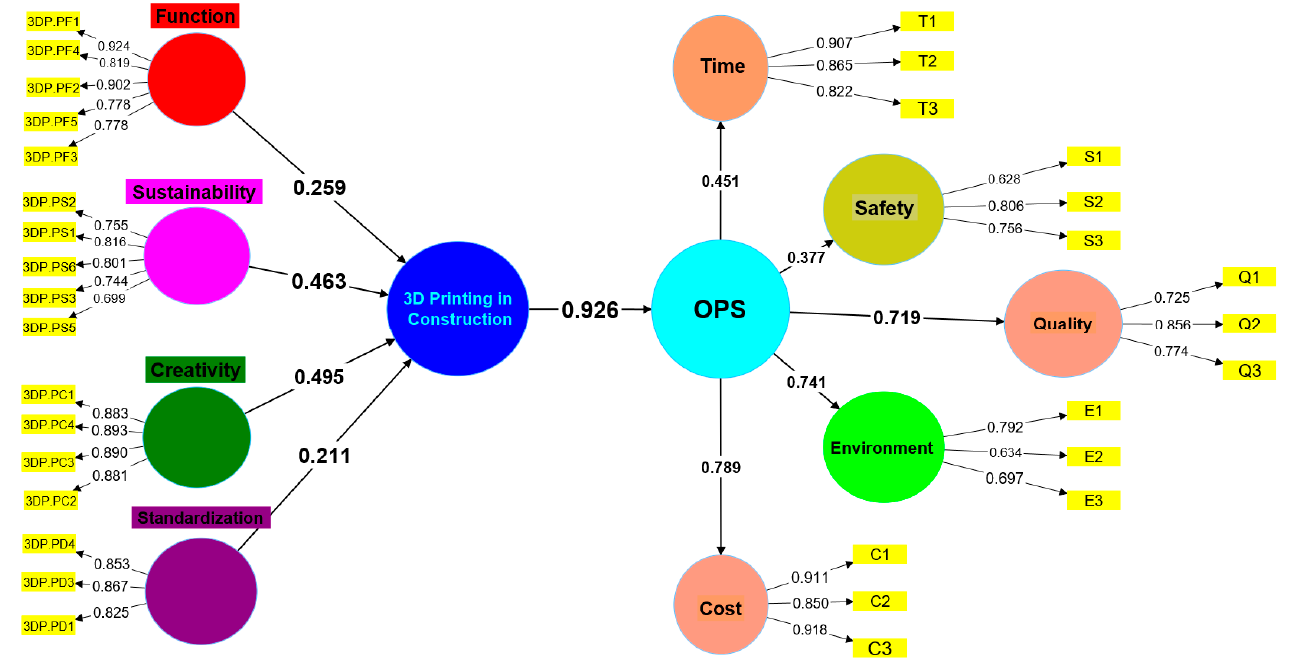
Figure 4. Structural model with path coefficients. Table 5. Correlations of latent variables and discriminant validity. Table 4. Construct initial loadings, modified loadings, and reliability